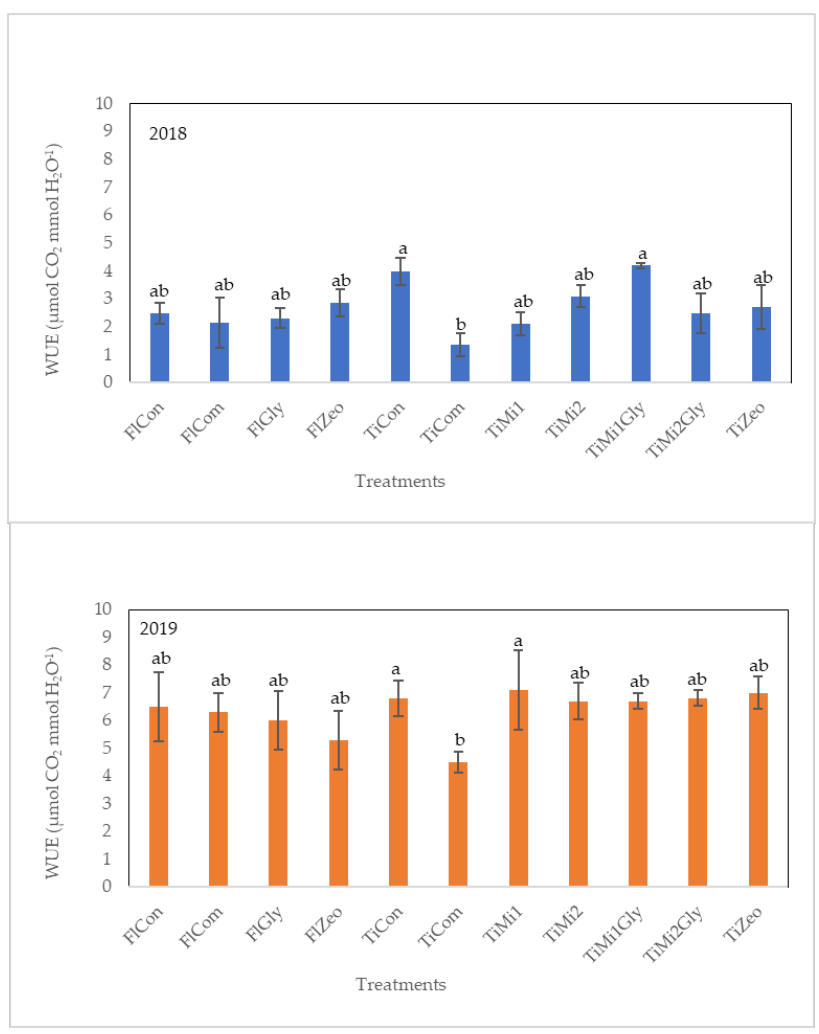
Figure 4. Water Use Efficiency (WUE, calculated as A/E checked in the morning between 8:30 and 11:00 a.m. in July, 50 DAMB, third year). Data are the mean of 4 replicates. The letters on the columns show significant differences between the treatments according to ANOVA, least significant difference (LSD) analyses at p -value threshold ≤ 0.05. Error bars represent standard deviation. FlCon: flat soil, without any addition; FlCom: flat soil, with addition of compost (130 t ha − 1 ); FlGly: flat soil, with addition of glycine-betaine; FlZeo: flat soil, with addition of zeolite; TiCon: soil tilled to form raised ridges of about 50 cm in rows, without any addition; TiCom: soil tilled to form raised ridges of about 50 cm in rows, with addition of compost (80 t ha − 1 ); TiMi1: soil tilled to form raised ridges of about 50 cm in rows, with addition of microbial consortium 1; TiMi2: soil tilled to form raised ridges of about 50 cm in rows, with addition of a microbial consortium 2; TiMi1Gly: soil tilled to form raised ridges of about 50 cm in rows, with addition of a microbial consortium 1 and addition of glycine-betaine; TiMi2Gly: soil tilled to form raised ridges of about 50 cm in rows, with addition of a microbial consortium 2 and addition of glycine-betaine; TiZeo: soil tilled to form raised ridges of about 50 cm in rows, with addition of